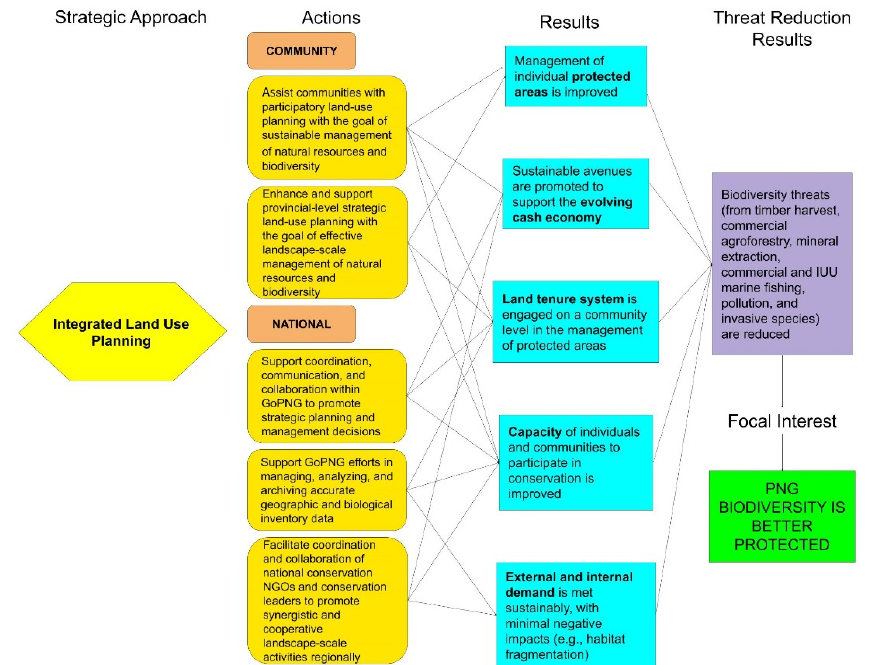
Figure 7. Results Chain for strategic goal of Integrated Land Use Planning in Papua New Guinea.